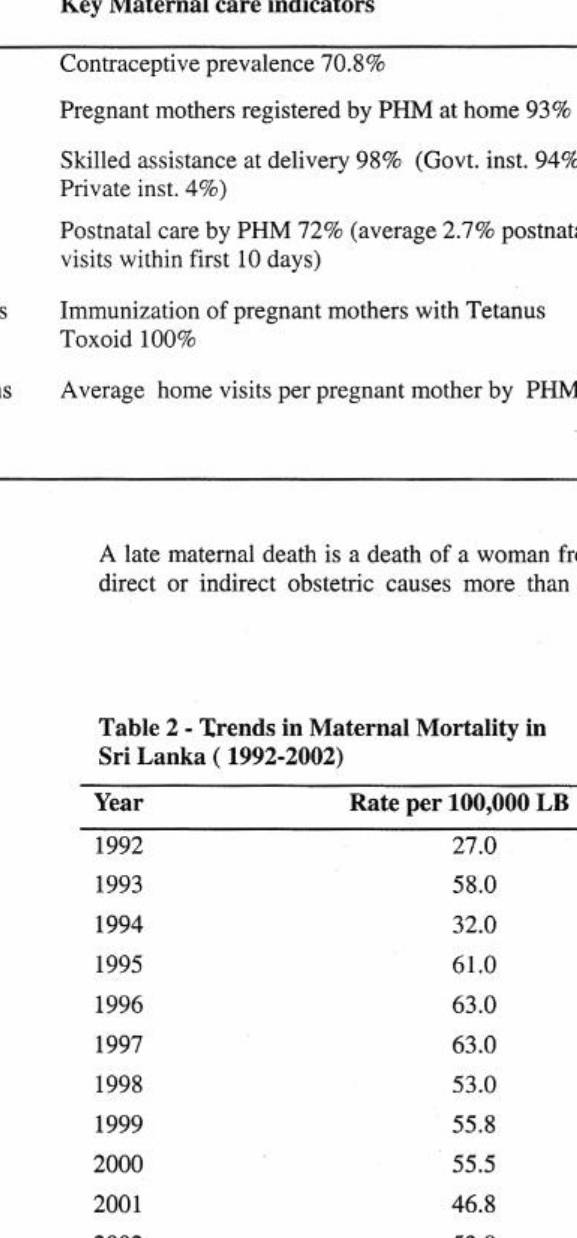
Table 1- Key demographic and maternal care indicators for the year 2002 in Sri Lanka Key Maternal care indicators